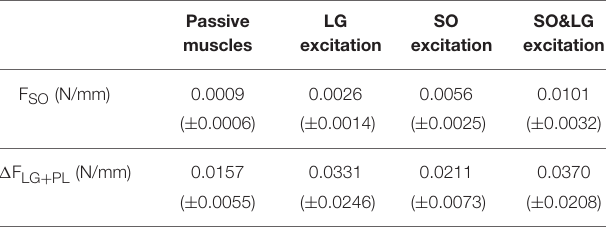
TABLE 1 | Extent of mechanical interaction expressed as the mean slope of F SO and 1 F LG+PL based on the values averaged across animals for various muscle